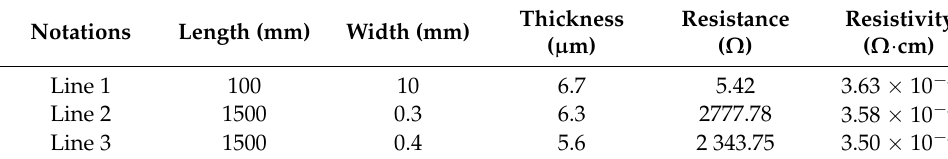
Table 2. The average resistivity of three different conductive film patterns.